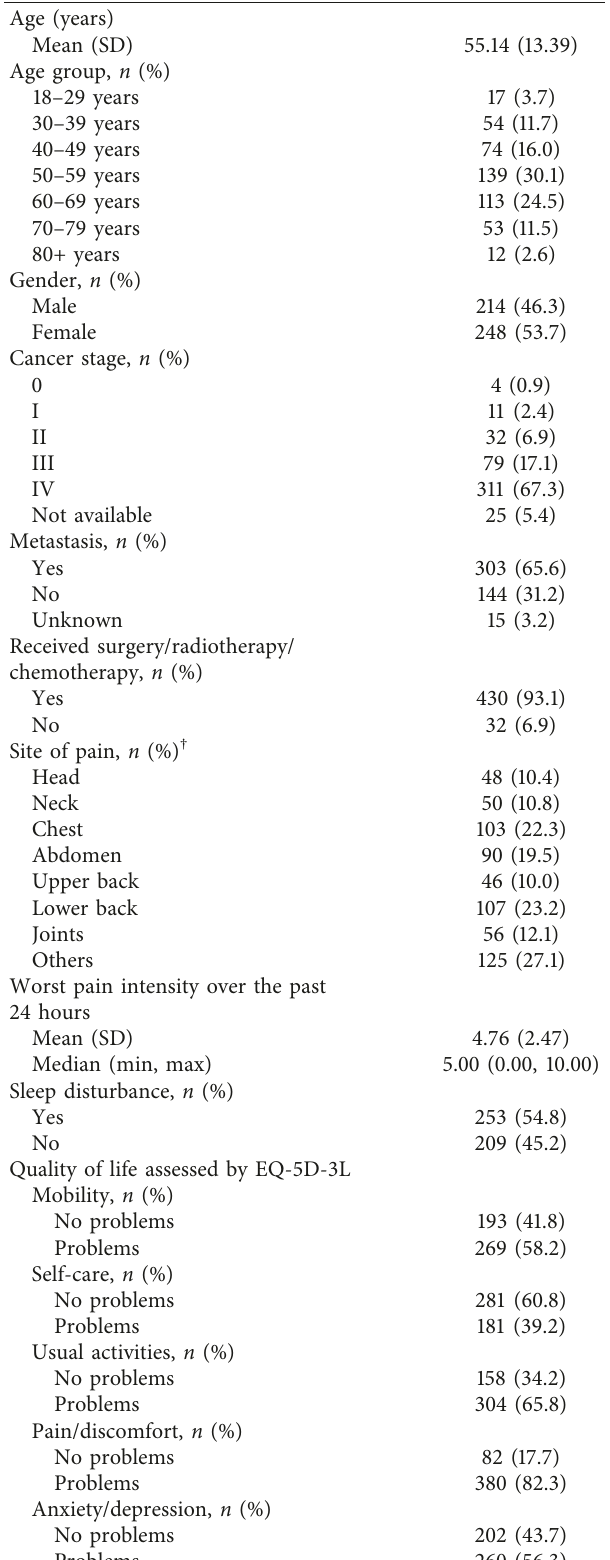
Table 1: Demographics and characteristics of the analysis pop- ulation ( n �